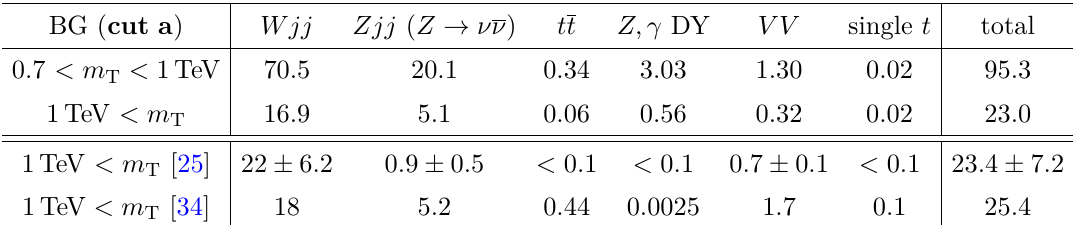
Table 1 . Expected number of SM background events after cut a (the τ ± ν search) for R L dt = √ s = 13 TeV in each background category. The last two rows show the results obtained 35 . 9 fb − 1 and by refs. [25] and [34]. Also shown are the total systematic uncertainties for the former. Detailed cut flows are shown in table 9.